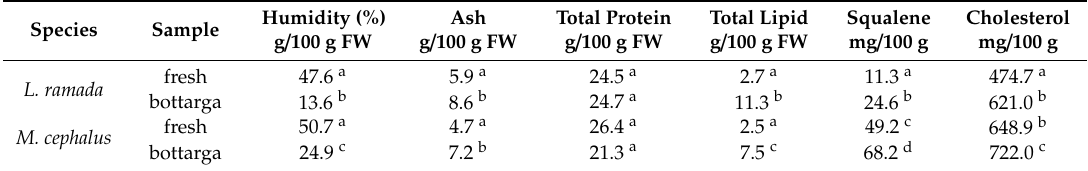
Table 1. Chemical–physical analysis, total protein, total lipid (g / 100 g, FW), squalene, and cholesterol (mg / 100 g, FW) of fresh roe and bottarga from M. cephalus and L. ramada .